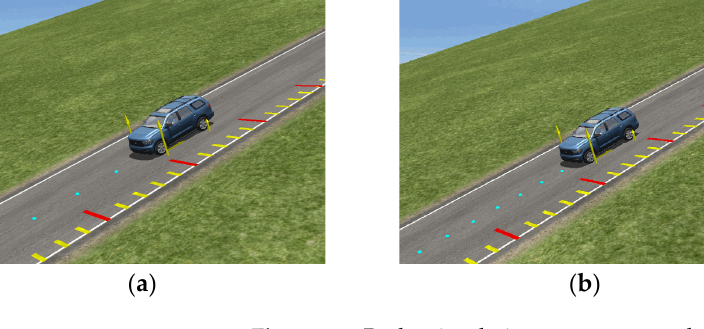
Figure 13. Brake simulation process on a sloped road: ( a ) uniform acceleration; ( b ) brake with a certain deceleration; ( c ) stopped.